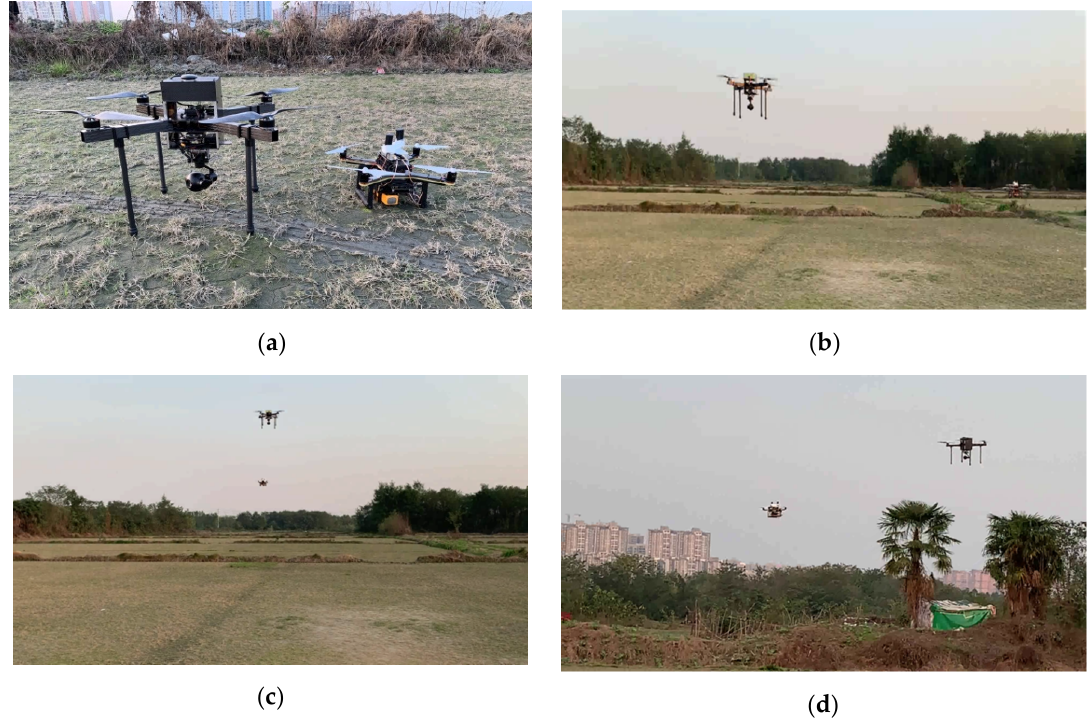
Figure 19. Autonomously tracking a flying drone with the experimental platform. ( a ) the target drone and the interceptor (the quadrotor platform); ( b ) the searching phase; ( c ) start the tracking phase when the target is recognized; ( d ) keep following the target drone.